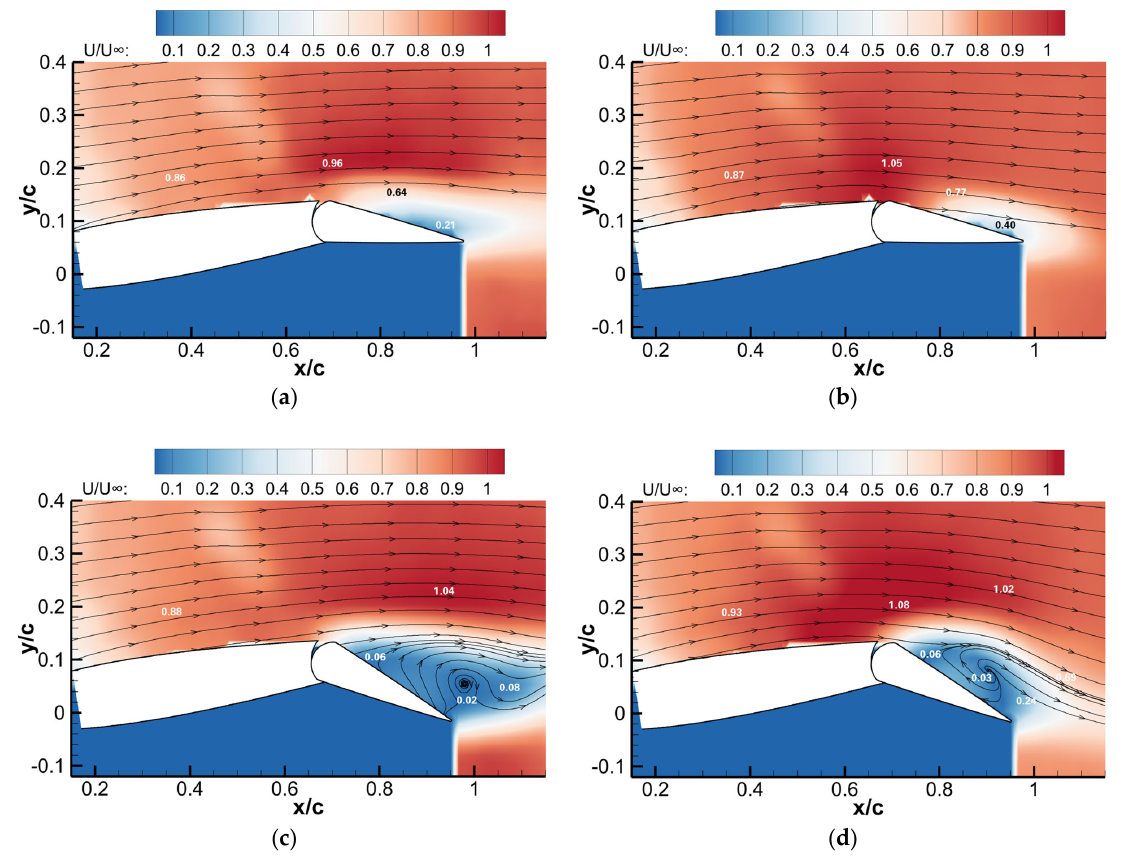
Figure 16. Velocity cloud diagram and streamline diagram of vertical tail upper surface: ( a ) C μ = 0, δ = 15°; ( b ) C μ = 0.332%, δ = 15°; ( c ) C μ = 0, δ = 30°; ( d ) C μ = 0.332%, δ = 30° ( β = − 10°, Re = 2.12 × 10 5 ).